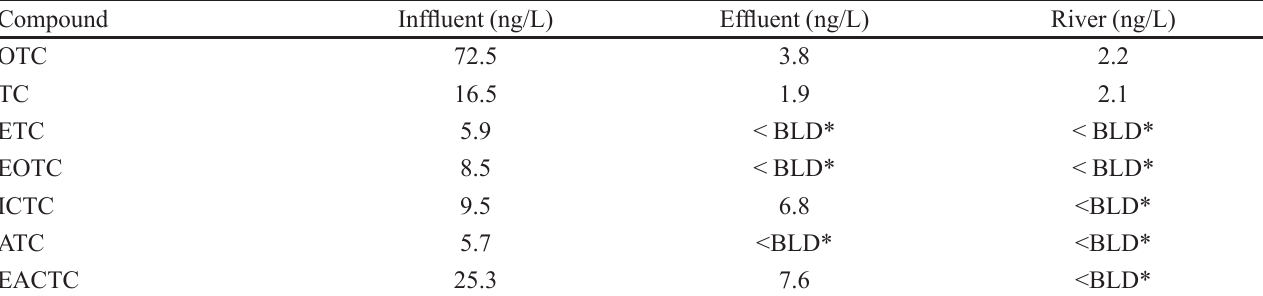
*<BLD = below limit of